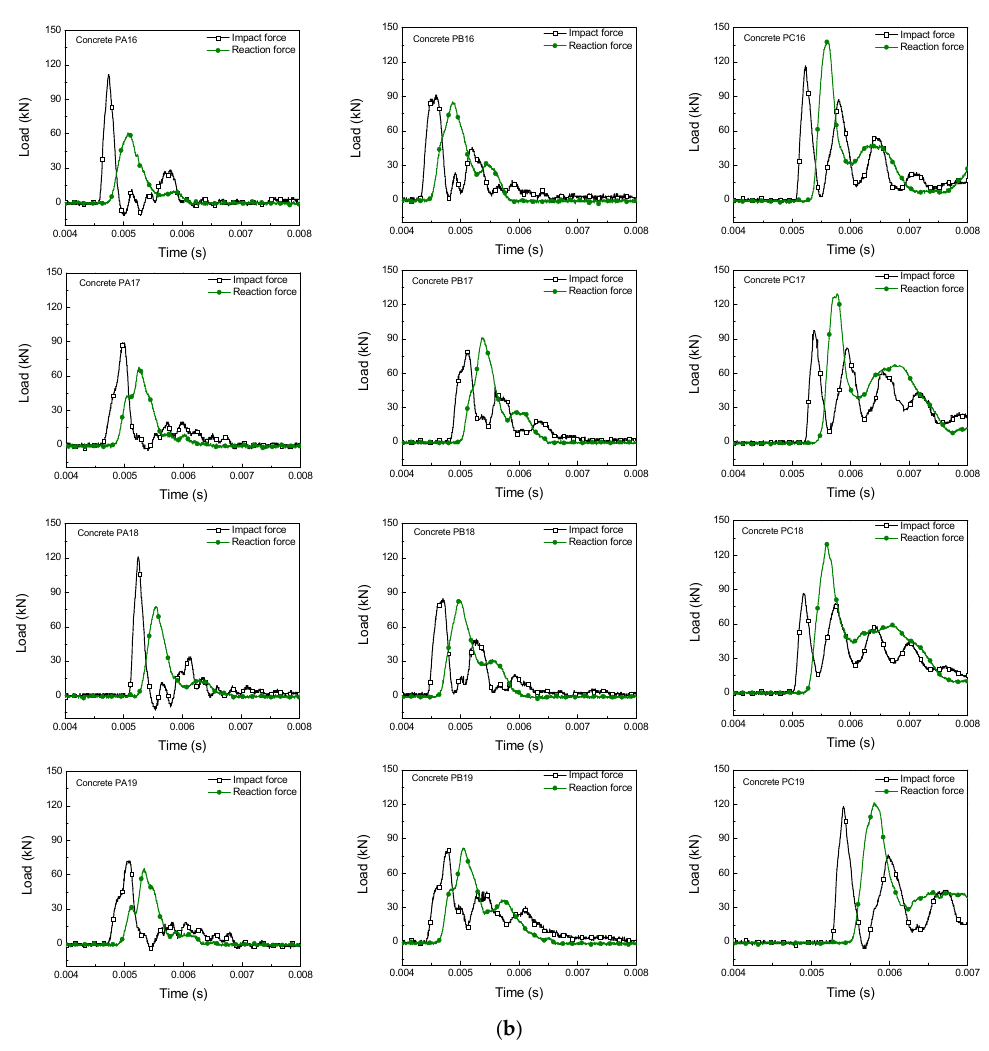
Figure 6. Impact and reaction forces versus time at different impact rates. ( a ) Hammer drop height 160 mm, loading rate 1.77 × 10 3 mm/s; ( b ) Hammer drop height 360 mm, loading rate 2.66 × 10 3 mm/s.